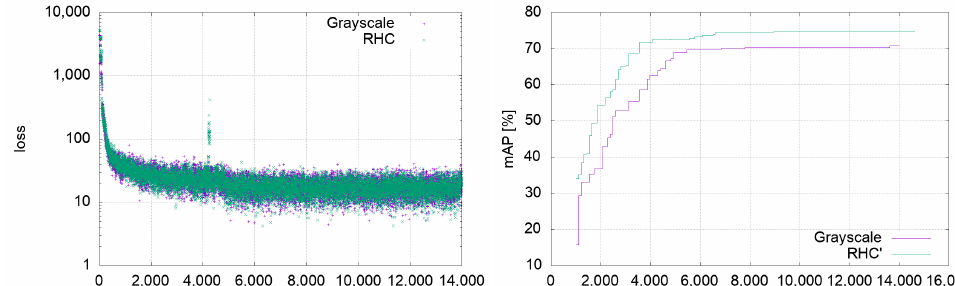
Figure 17. Learning curves in the second sets of experiments for grayscale images and RHC im- ages: in the left inset , the loss change is shown; in the right inset , the best-so-far mean average precision (mAP) is